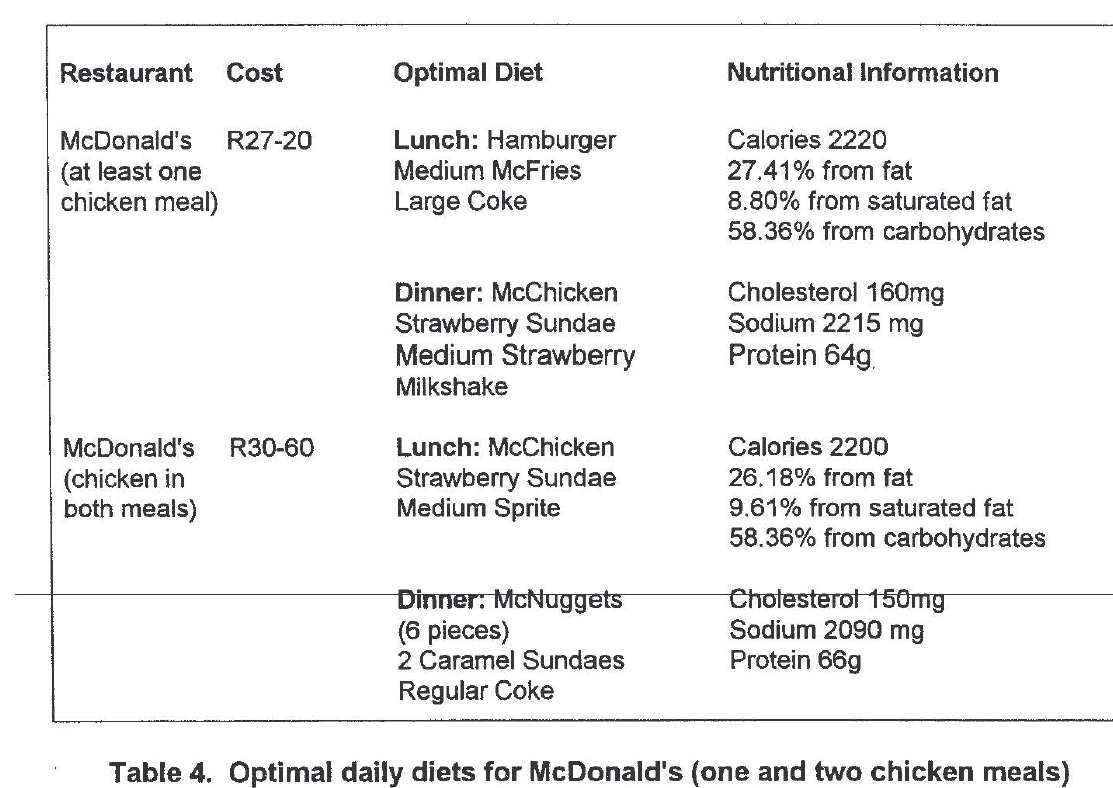
Table 4. Optimal daily diets for McDonald's (one and two chicken meals)